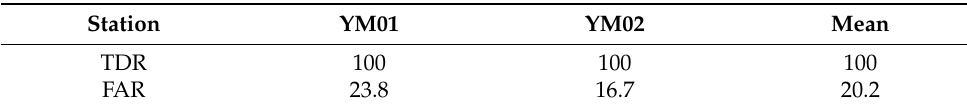
Table 6. Statistical results of TDRs and FARs of the combined linear–nonlinear rainfall forecast model at the YM01 and YM02 stations.